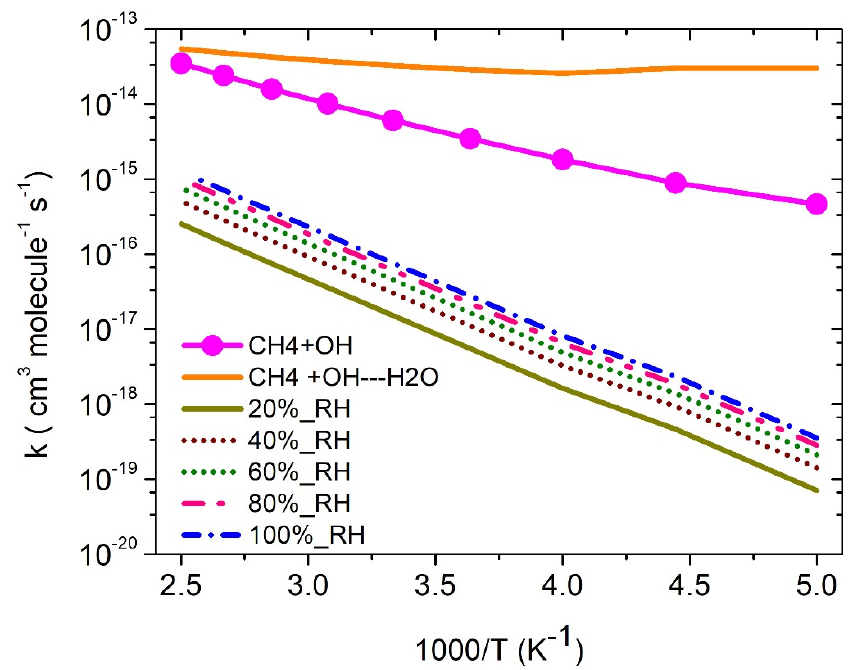
Figure 6. Rate constants for · OH + CH 4 + (H 2 O) with different relative humidity. CH 4 + H 2 O···OH is the rate constants without water concentration. The water concentration at this humidity is taken from our earlier studies [21,27]. The presented rates are the relative humidity of water from 20% to 100%.